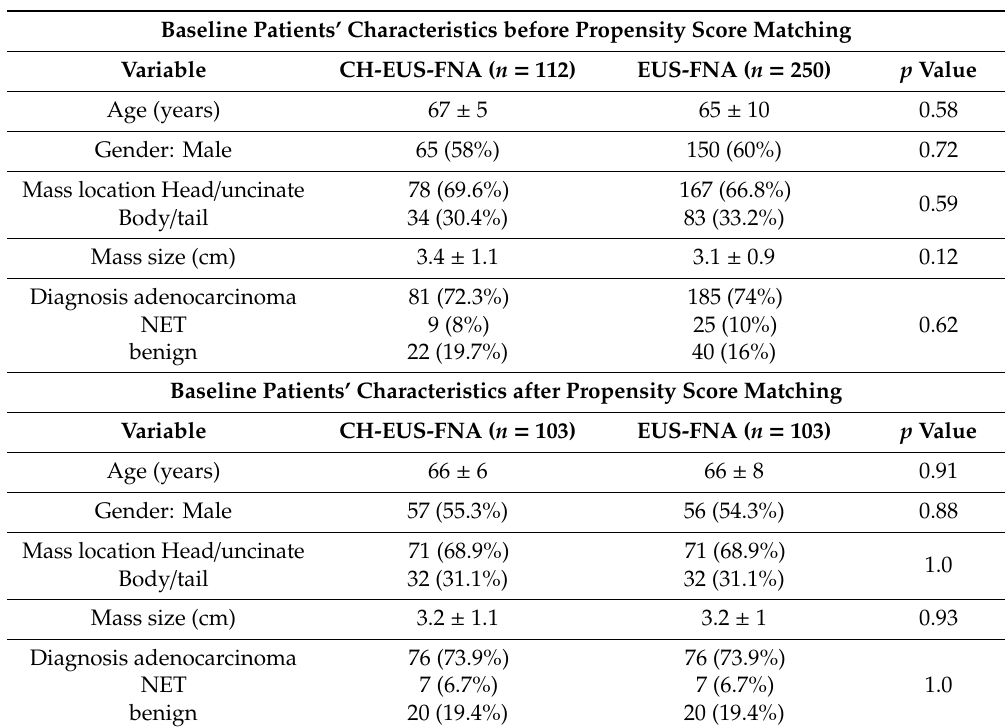
Table 1. Baseline characteristics of the patients recruited in the